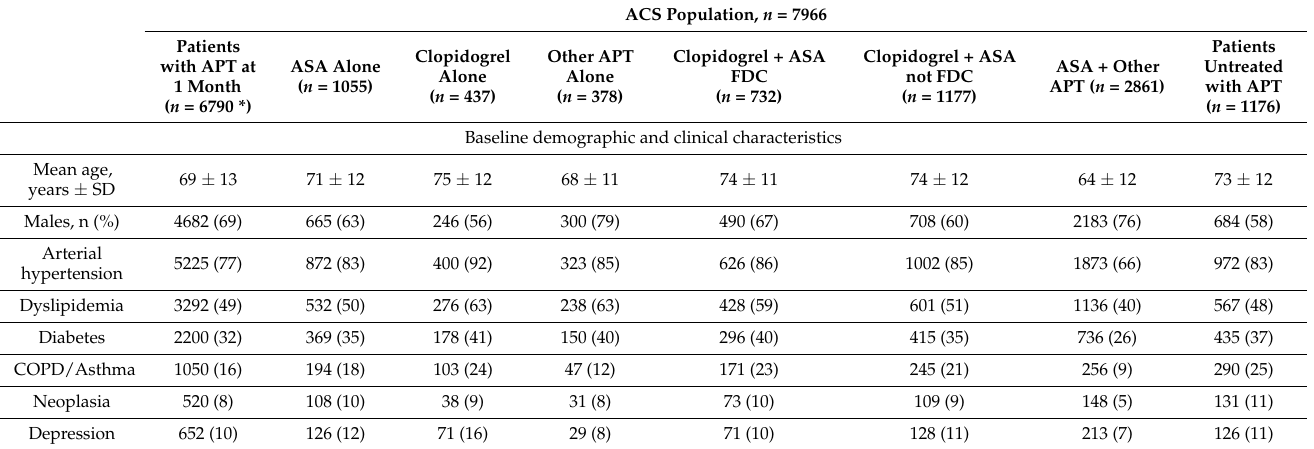
Table 1. Baseline characteristics of the acute coronary syndrome population stratified by type of antiplatelet therapy at one month.